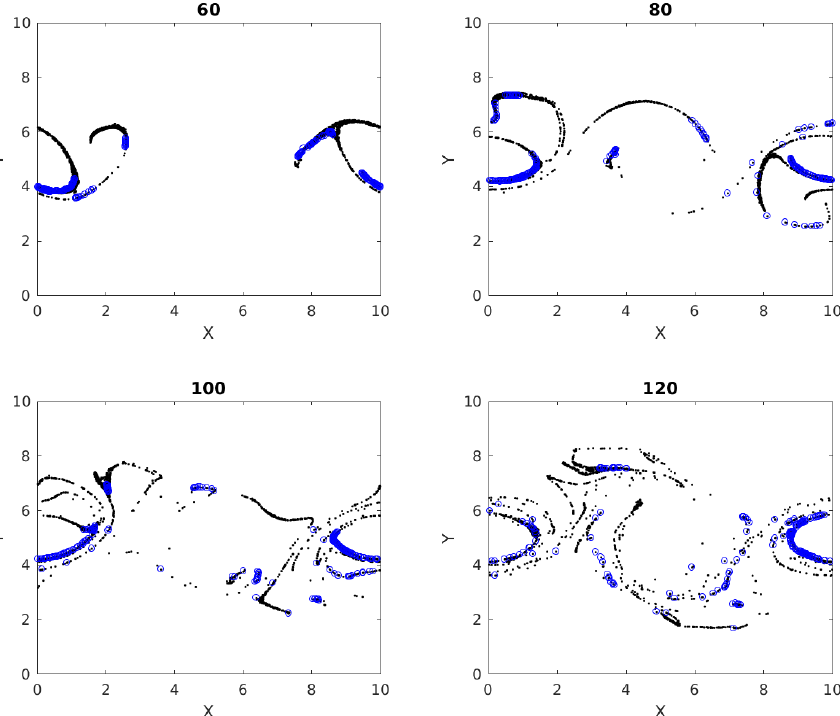
Figure 8. Multiple time images of cumulative cluster 2 (black) with its dense subclusters (blue). Blue circles at later times represent particles that were parts of a dense subcluster at time